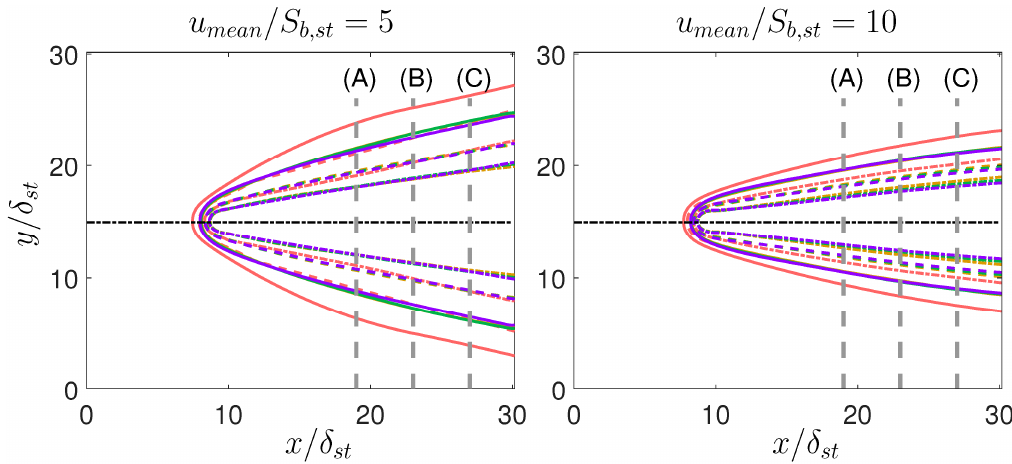
Figure 4. Contours of 𝑐̃ = 0.1 (solid line), 0.5 (dashed line) and 0.9 (dotted line) contours for gaseous premixed ( ) case and droplet cases with initial droplet diameter 𝑎 (cid:3031) 𝛿 (cid:3046)(cid:3047) ⁄ = 0.04 ( ), 0.05 ( ) and 0.06 ( ) with 𝑢 (cid:3040)(cid:3032)(cid:3028)(cid:3041) 𝑆 (cid:3029),(cid:3046)(cid:3047) ⁄ = 5.0 (left) and 10.0 (right). The dashed grey lines show the sampling locations (A, B, C from left to right), and the dotted black line shows the flame centre.